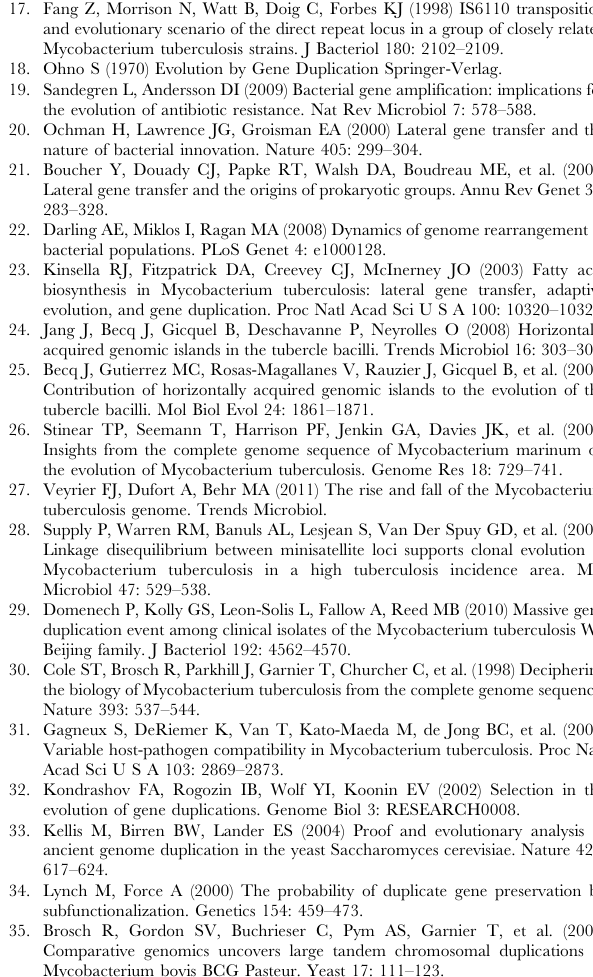
Figure S2 Coverage plot showing RD105: 79,567 to